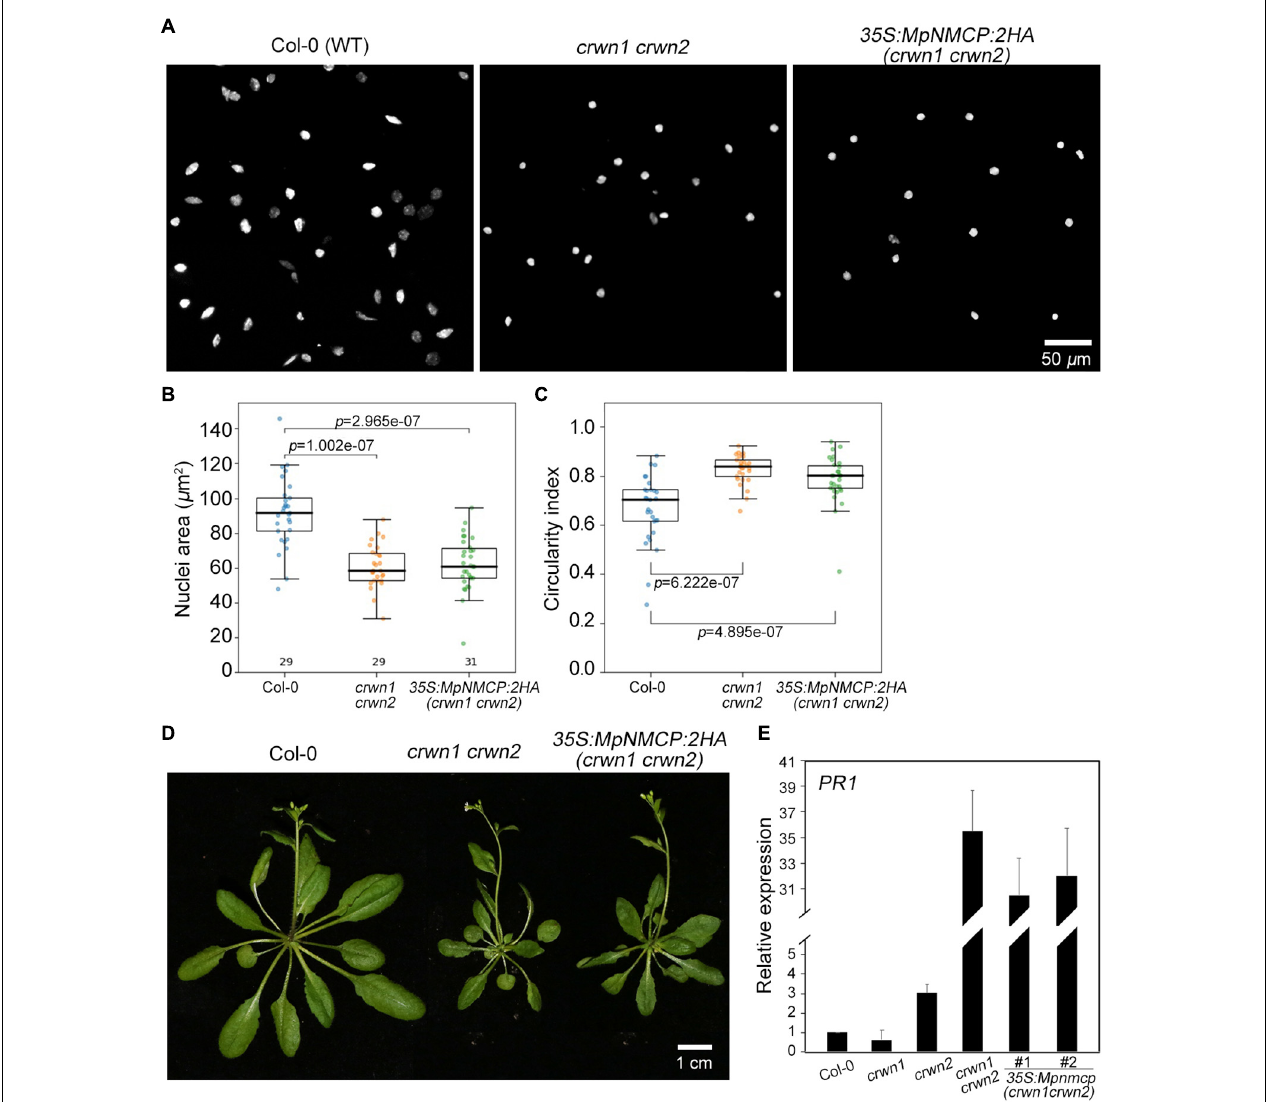
FIGURE 4 | MpNMCP could not complement Arabidopsis crwn mutants. (A) Comparison of 8C nuclei morphology. The nuclei were isolated from the first true leaf of 2-week-old seedlings. 4 (cid:48) ,6-Diamidino-2-phenylindole (DAPI) staining (blue) was used for visualization of nuclei. Scale bar, 50 µ m. (B,C) Comparison of nuclear morphology. Quantifications of nuclear size (B) and nuclear circularity index (C) in Col-0, crwn1 crwn2 , and crwn1 crwn2 35S:MpNMCP-2HA . (D) Phenotypes of transgenic Arabidopsis plants over-expressing MpNMCP:2HA . Scale bar, 1 cm. (E) The relative expression level of PR1 in different mutants detected by real-time PCR. Values were normalized to the expression of ubiquitin 5 ( UBQ5 ). Error bars display ± SD. PR1 expression in individual biological replicates is set as